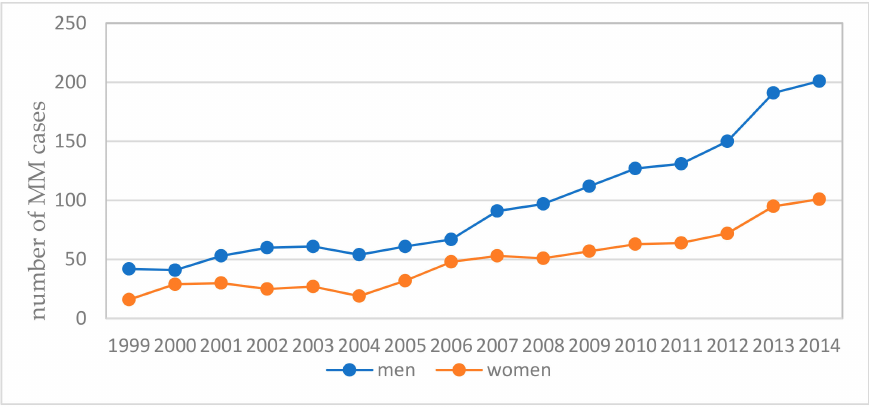
Figure 7. The number of registered MM cases in Poland.